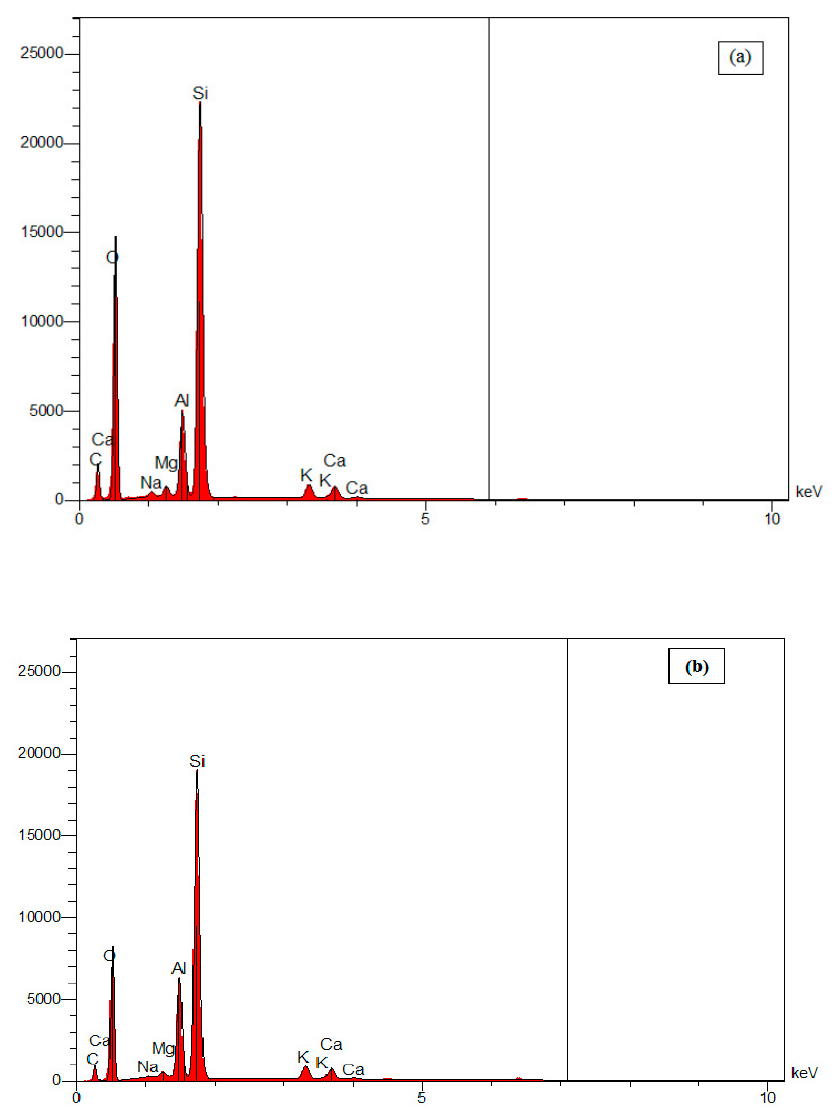
Figure 3. EDX spectra of the kaolin/sand ( a ) and kaolin/zeolite ( b ) membranes.